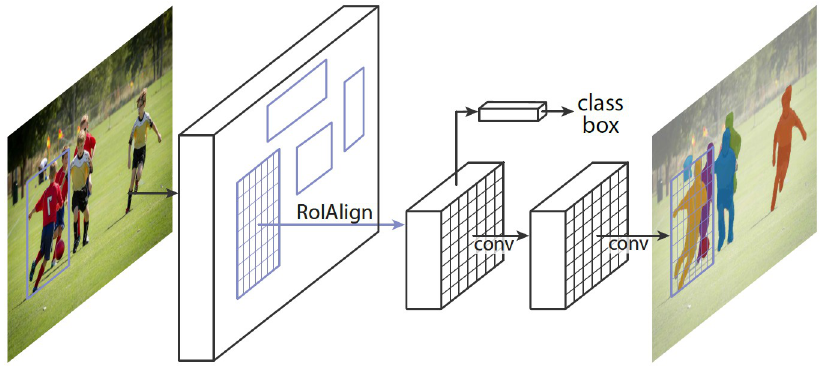
Fig 2. Mask R-CNN framework